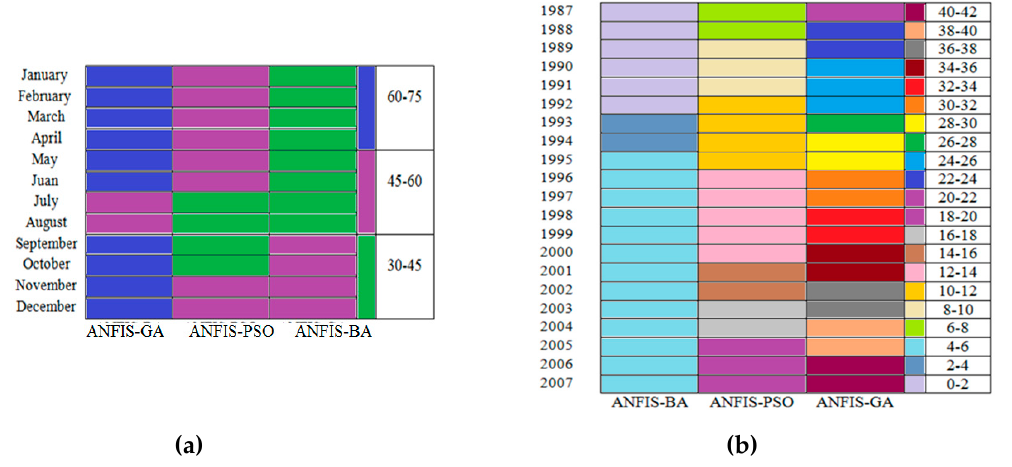
Figure 7. ( a ) relative error based on percentage and ( b ) LEPS score.